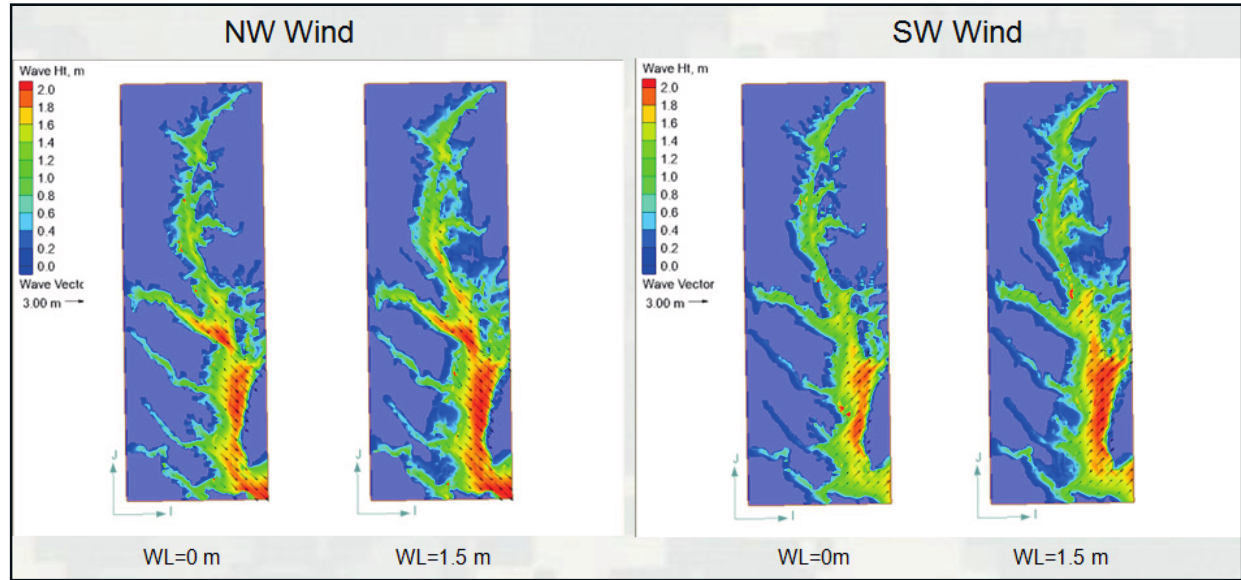
Figure 11. Water levels at Bay Bridge Tunnel (8638863) and Windmill Point (8636580), VA, for September 2003.